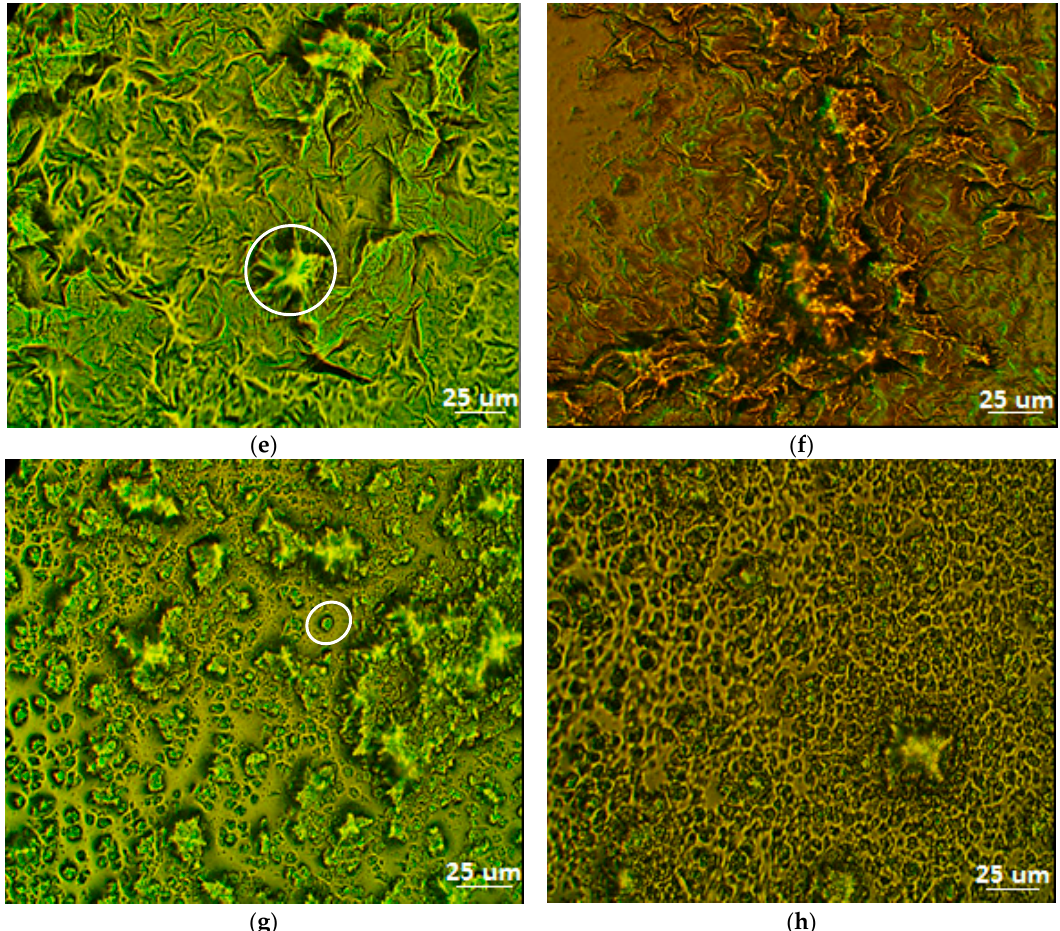
Figure 4. Phase contrast microphotographs (left panel) and fluorescence microphotographs (right panel) of lemon essential oil matrixes prepared with beewax ( a , b ), candelilla wax ( c , d ), ozokerite wax ( e , f ), and carnauba wax ( g , h ).